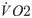
V˙O2 and propulsive force vs distance for the 1300 meters race.V˙O2 (left in green) and propulsive force (right): blue is the propulsive force f(s) in the direction of movement, black is the effective propulsive force ftot=f2+c2v4 taking into account the centrifugal force, where c is the curvature.